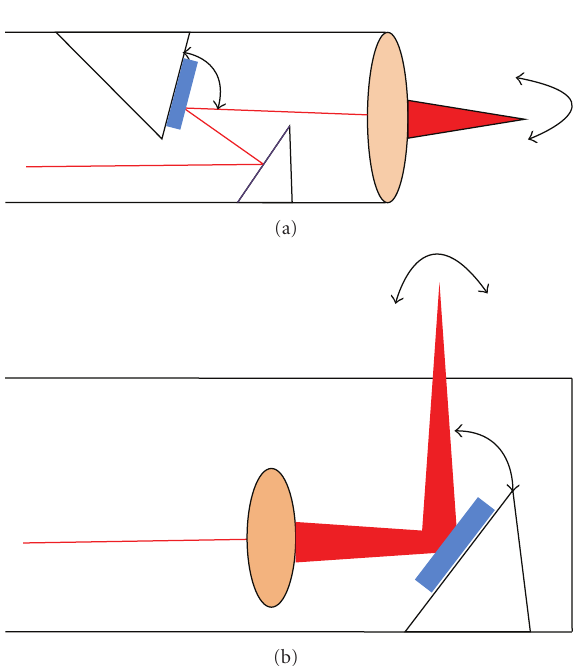
Figure 2: MEMS probe schematic representation. (a) forward-view probe, (b) side-view